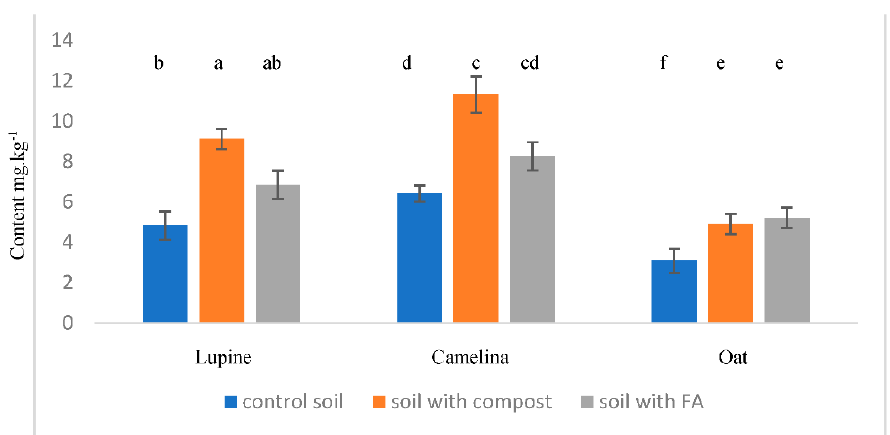
Figure 4. The average content and SD (for three years) of Pb amounts in plants for treatments. Homogeneous groups were determined using the Dunn test. In the figure the letters denote homogenous groups and numbers mean SD values.